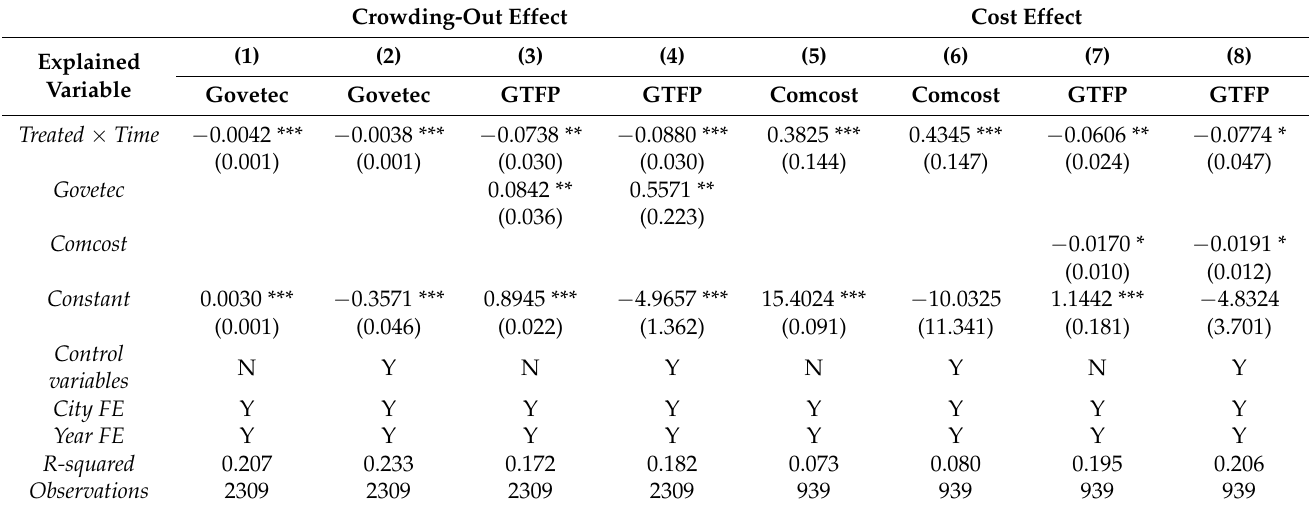
Table 8. The impact mechanism of WECP on